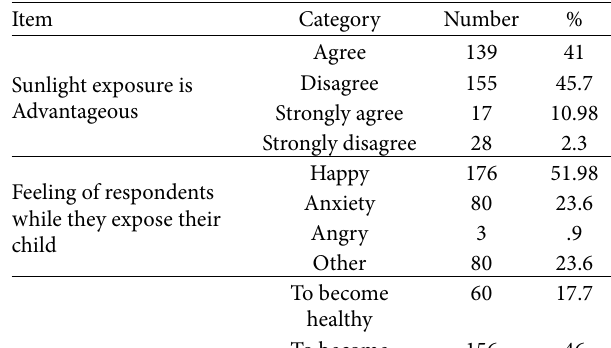
Starting day of sunlight exposure